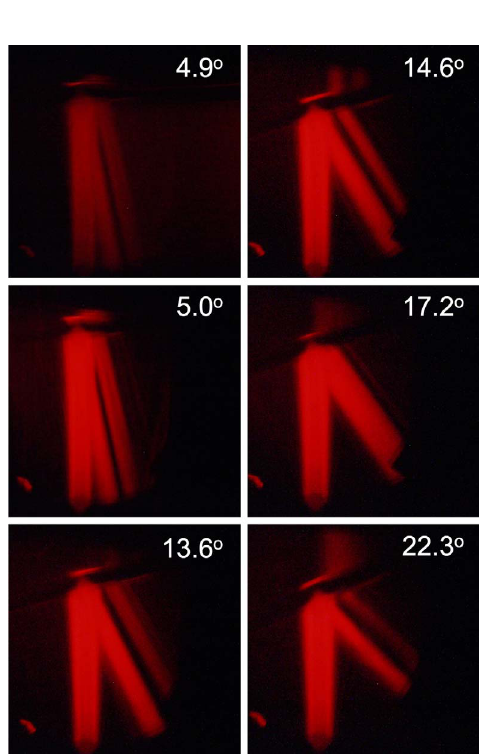
Figure 2. Illustration of the laminated glass